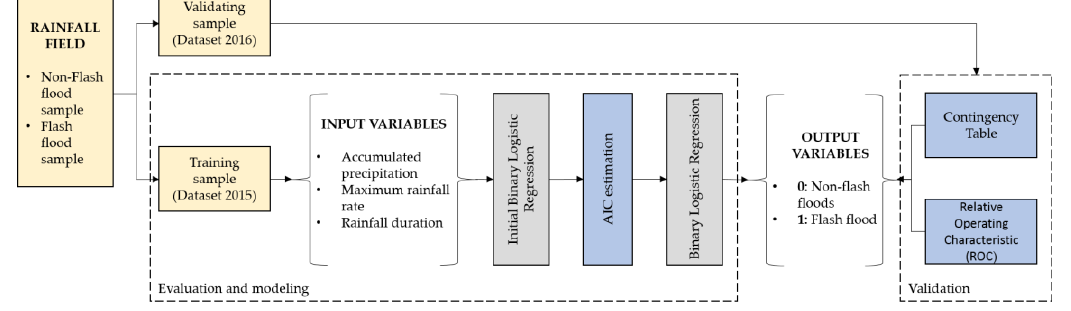
Figure 4. Methodological flowchart used in the binary logistic regression model.